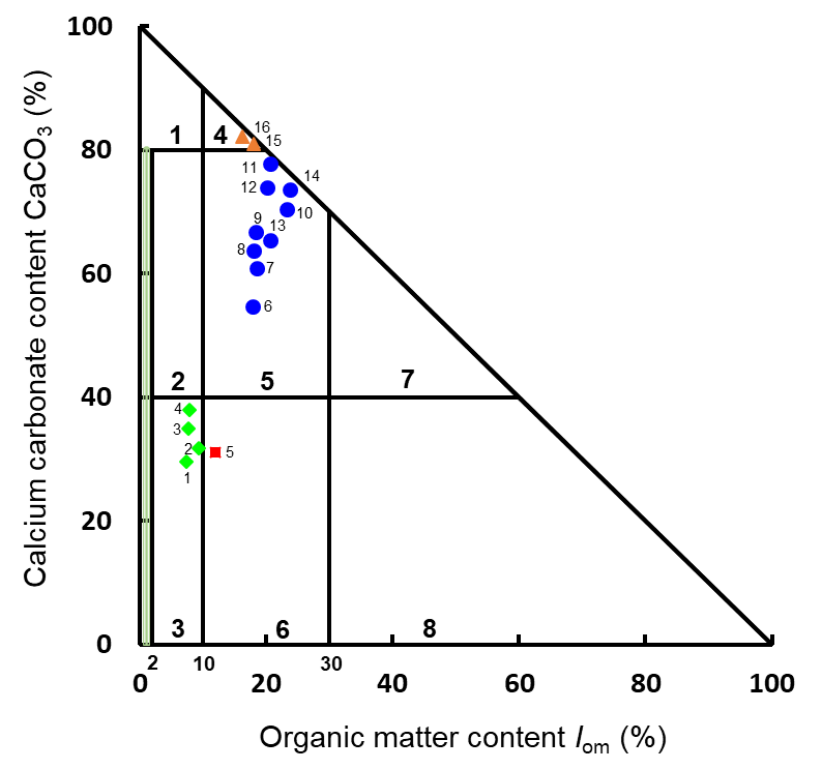
= 0%–2% mineral soils. om